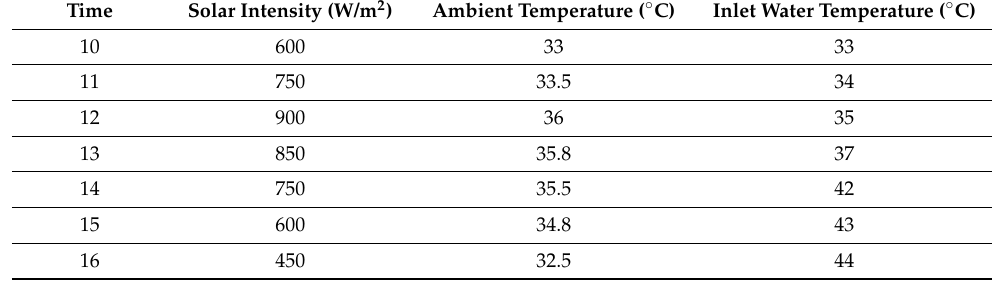
Table 2. Weather conditions of the PVT water collector [41].